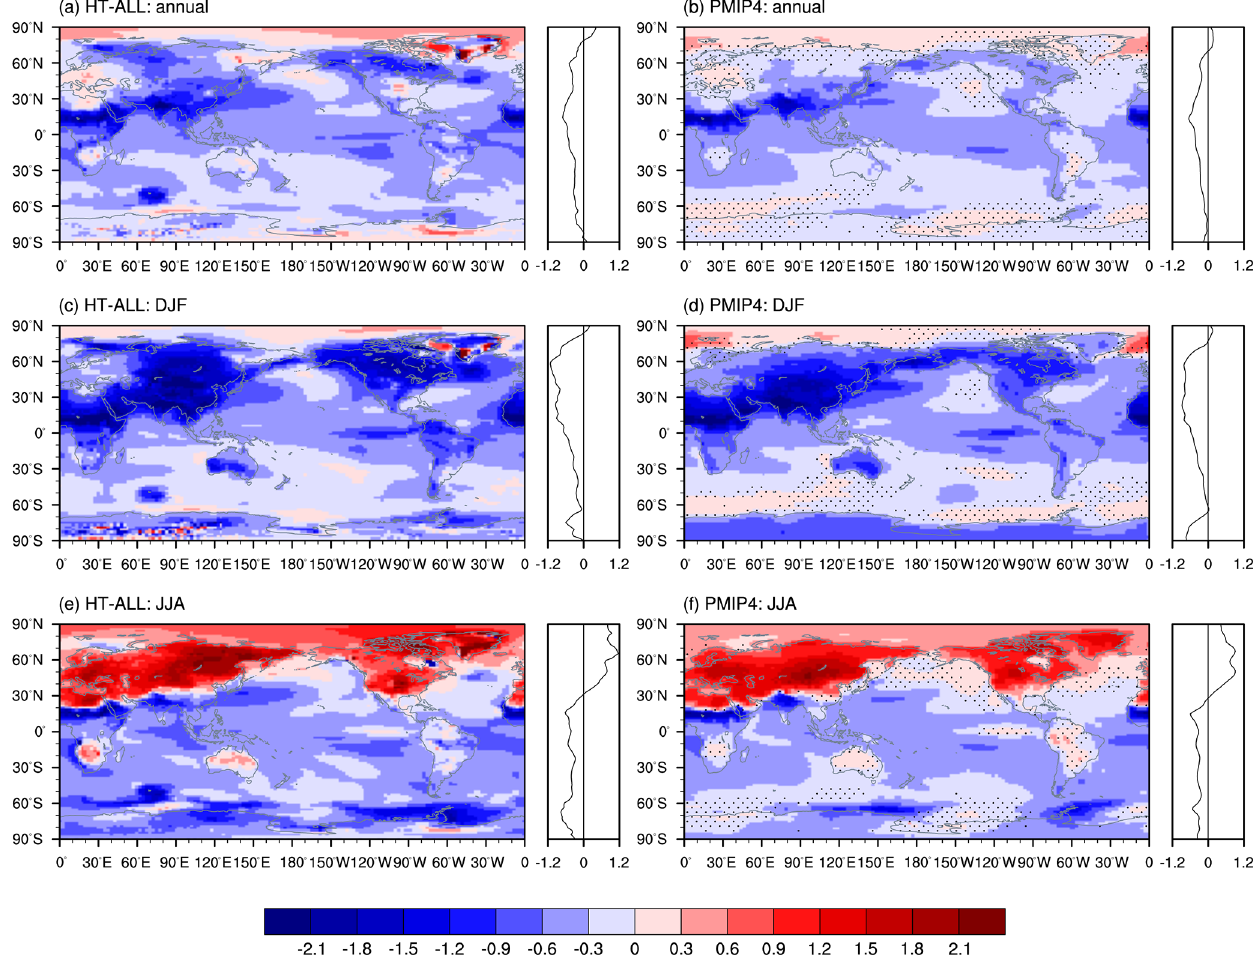
Figure 6. Changes in (a, b) annual, (c, d) DJF, and (e, f) JJA mean surface air temperatures (units in ◦ C) (a, c, e) between the averages for 6ka ± 0.05ka and the last 101 years (i.e., 1750–1850) in the HT-ALL simulation and (b, d, f) between the Middle Holocene and preindustrial simulations in the arithmetic mean of the 14 PMIP4 models, as listed in Fig. 5. The zonal mean changes are shown on the right of each panel. The dotted areas in (b) , (d) , and (f) represent less than 70% of the PMIP4 models agree with the sign of multimodel mean